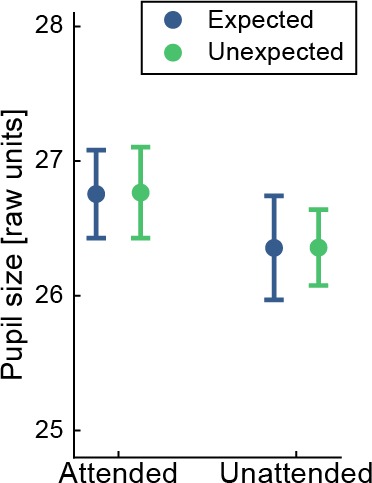
No difference in baseline pupil size between attention tasks, nor expectation conditions.Displayed are mean pupil sizes during the baseline period in raw units for expected and unexpected trials during the objects attended and unattended task. Pupil sizes during baseline were similar for trials with expected and unexpected object stimuli, as well as during both tasks. Error bars indicate within-subject SEM.